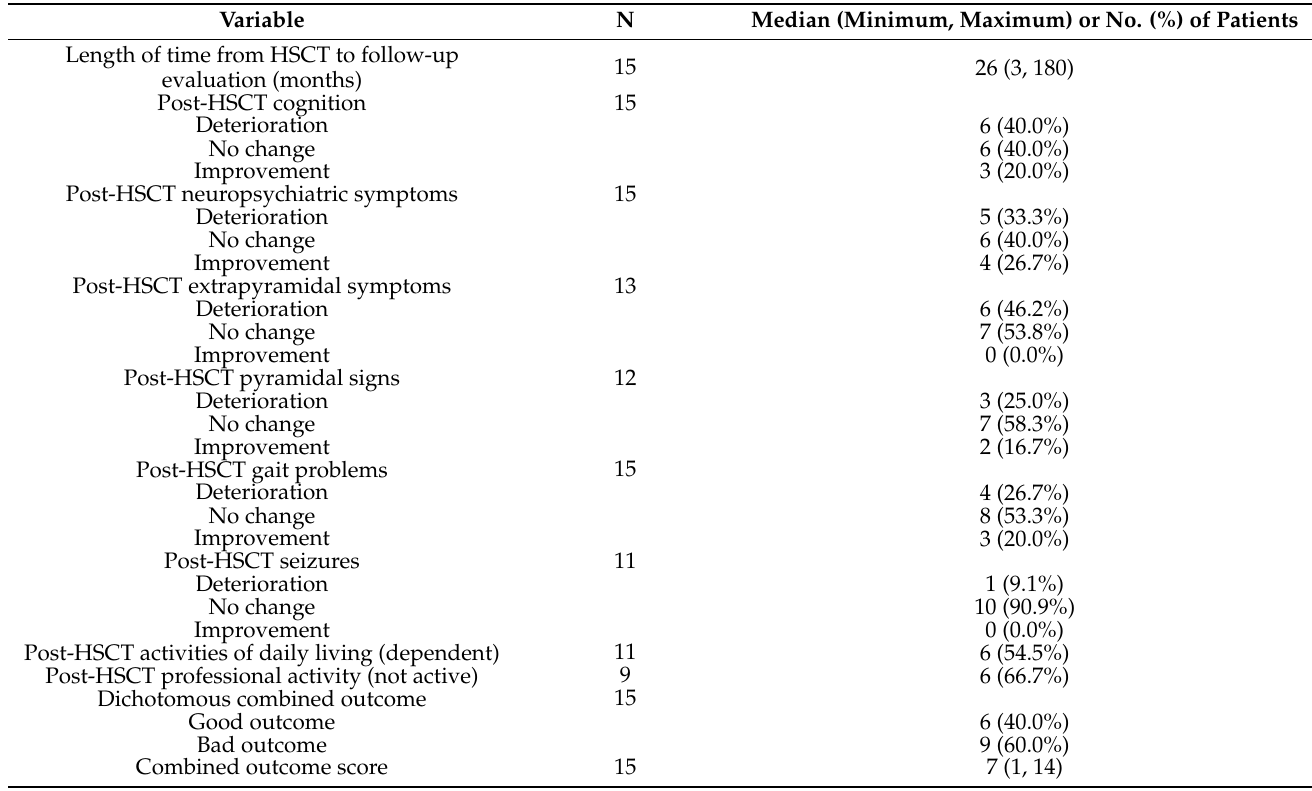
Table 3. Summary of post-HSCT